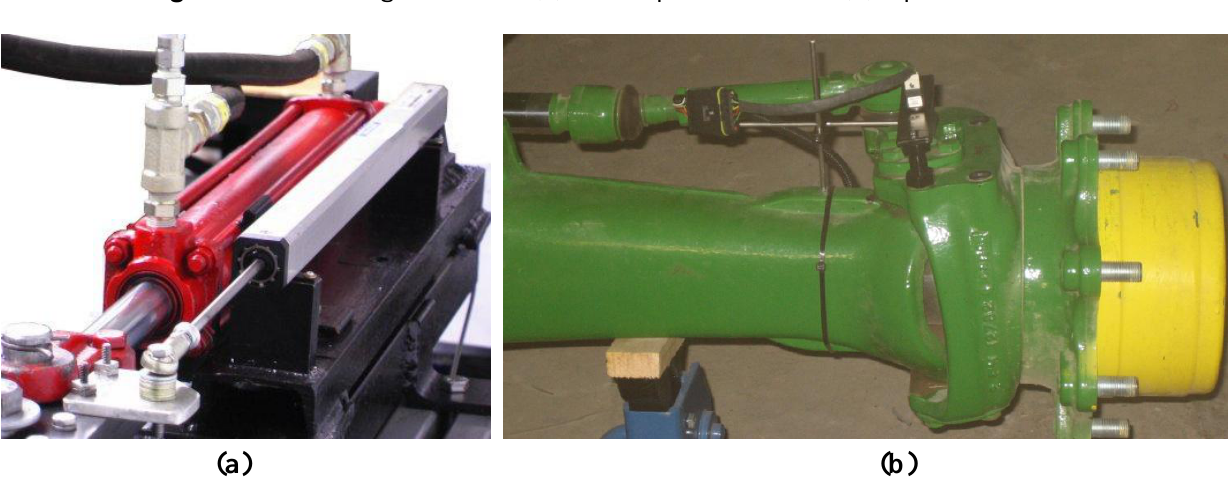
Figure 9. Wheel angle sensors: (a) Linear potentiometer. (b) Optical